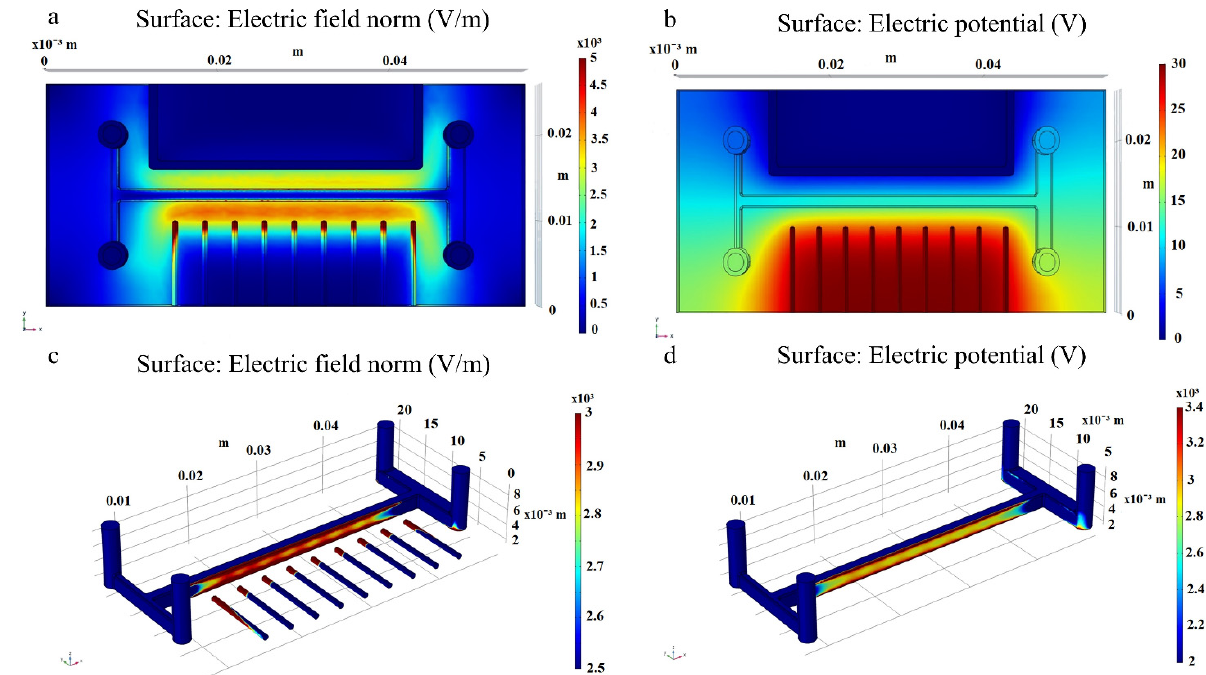
Figure 4. Electric field distribution (V/m) inside the bioreactor: ( a ) top view; ( c ) central channel-PE side; ( d ) central channel–PPE side, and ( b ) distribution of the electrical potential (V) within the microfluidic bioreactor (top view).